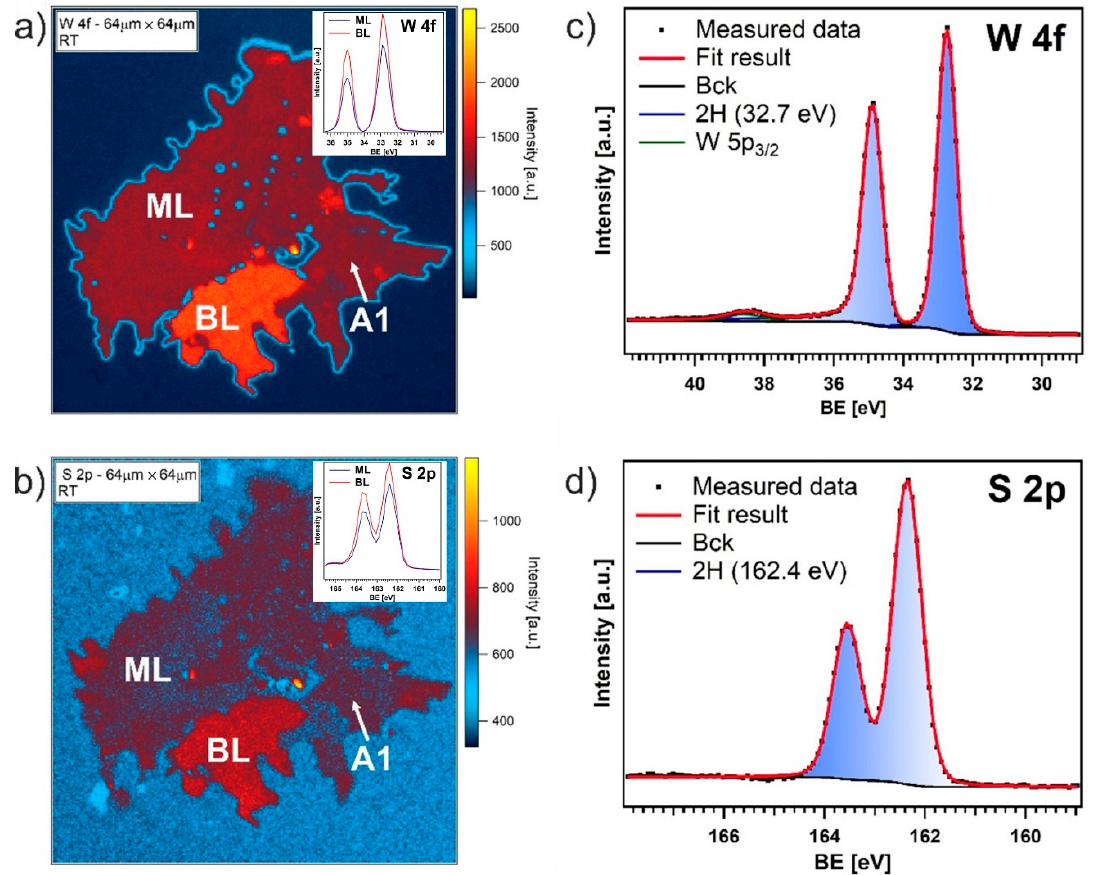
Figure 2. W 4f ( a ) and S 2p ( b ) SPEM maps recorded at room temperature (RT) in the binding energy (BE) range of 29.3–37.0 eV and 158.5–166.2 eV, respectively. W 4f ( c ) and S 2p ( d ) single energy distribution curve of microspot photoemission ( µ -PE) spectra acquired at A1